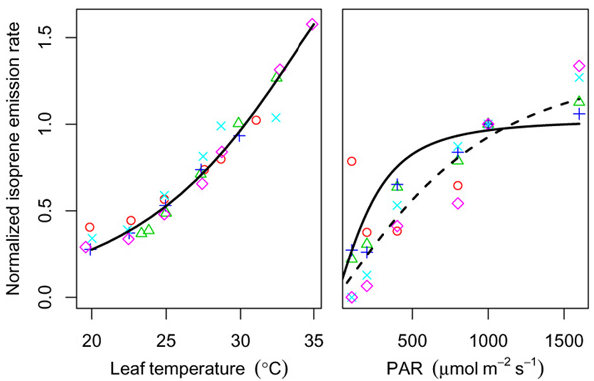
Fig. 2. Normalized isoprene emissions as a function of leaf temper- ature and light for S. pulchra leaves compared to the G93 algorithm (black curves). The dashed curve in the right-hand panel is the same algorithm with the α and C L 1 parameters in Eq. (2) optimized to fit the data. The individual sets of measurements from the same leaf are denoted by the same colour and type of plotting character.